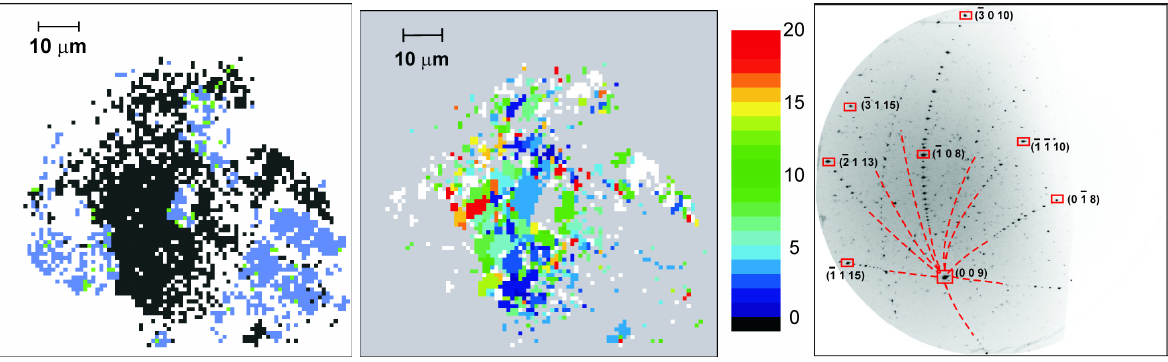
Figure 9. From left to right: Typical results from white beam X-ray microdiffraction showing a map of the phase distribution (Re N and Re in black and blue areas, respectively), 3 the distribution of the grains and their sizes ( ≈ 3–8 µ m) derived from the c -axis orientation of Re N, and an image indexed with the unit cell of Re N [60]. The indices of a few 3 3 reflections are shown as examples. The red dashed curves indicate extensions of the indexed Laue